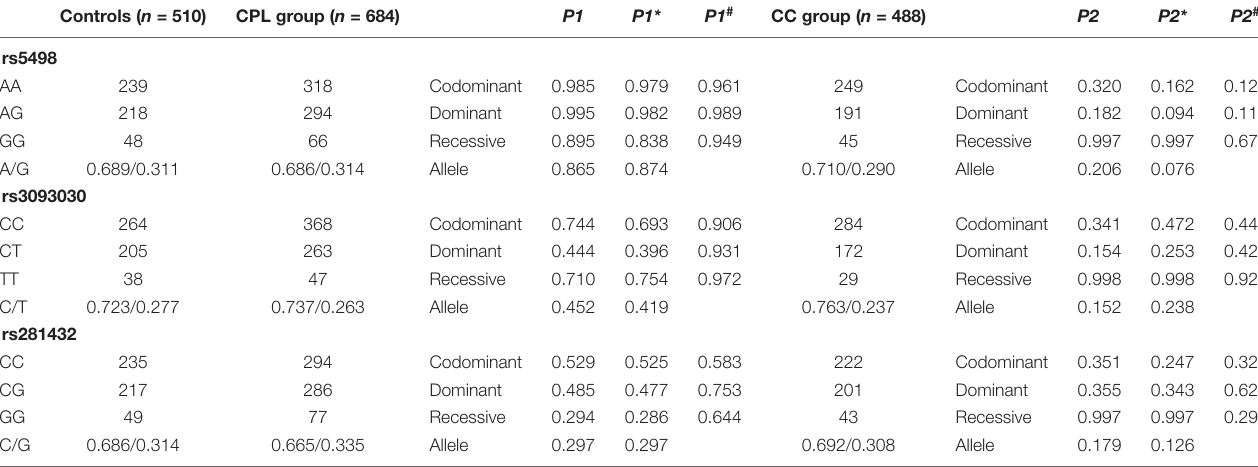
TABLE 4 | The distribution of the three SNP genotypes and alleles of the ICAM-1 gene in the cervical precancerous lesion group and the control group. Controls ( n = 510)